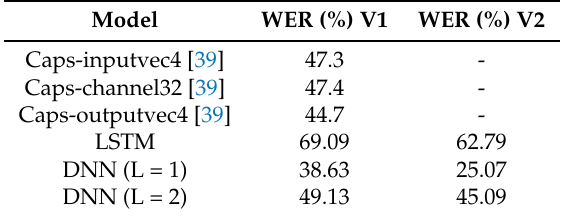
Table 6. WER of deep models trained on clean data and tested on noisy data.